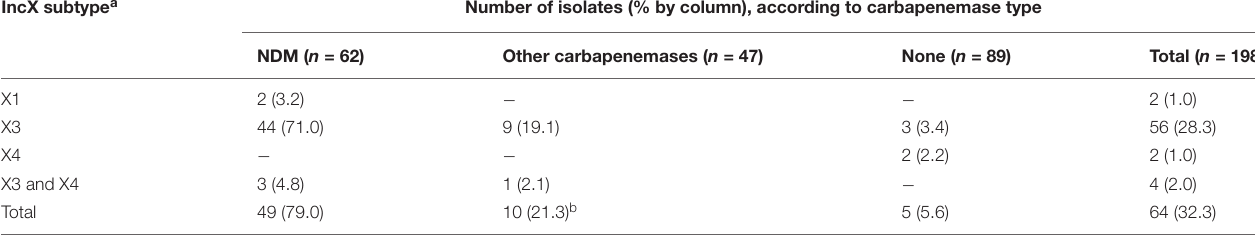
TABLE 1 | IncX replicons among 198 carbapenem-resistant Enterobacteriaceae isolates. IncX subtype a